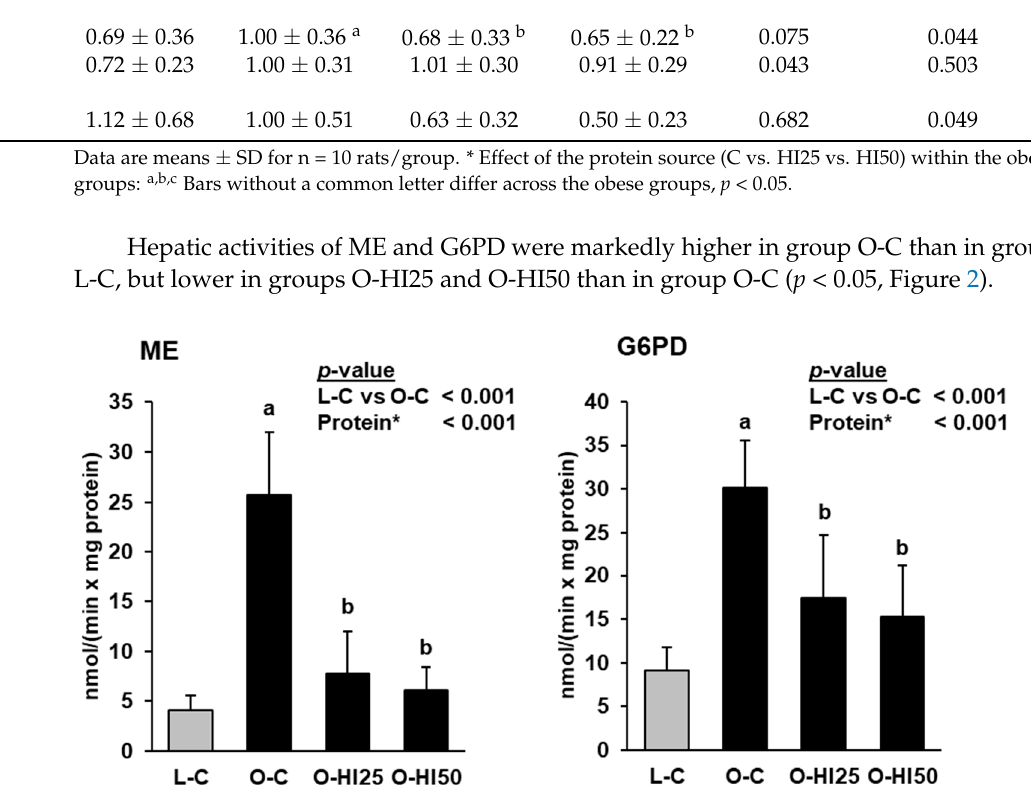
Figure 2. Hepatic activities of malic enzyme (ME) and glucose-6-phosphate dehydrogenase in the rats. Bars represent means ± SD for n = 10 rats/group. *Effect of the protein source (C vs. HI25 vs. HI50) within the obese groups: a,b Bars without a common letter differ across the obese groups, p < 0.05.